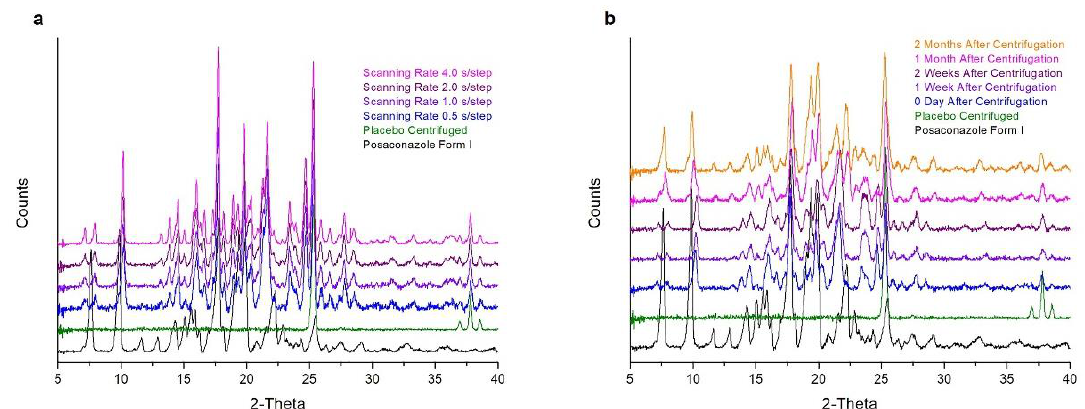
Figure 6. Stabilization of Posaconazole Form-S in the oral suspension ′ s precipitate after covering the sample with transparent food membrane: ( a ) the XRPD patterns of Posaconazole oral suspension ′ s precipitate recorded with different scanning rates at 0.5 s/step (blue line), 1.0 s/step (violet line), 2.0 s/step (purple line) and 4.0 s/step (magenta line); of the precipitate of Posaconazole oral suspension ′ s placebo (green line); and of Posaconazole Form I (black line) and ( b ) the XRPD patterns of Posaconazole oral suspension (cid:48) s precipitate immediately after centrifugation and enfolded with the transparent food membrane (blue line) after 1 week (violet line), 2 weeks (purple line), 1 month (magenta line) and 2 months (orange line); of the precipitate of Posaconazole oral suspension (cid:48) s placebo (green line); and of Posaconazole Form I (black